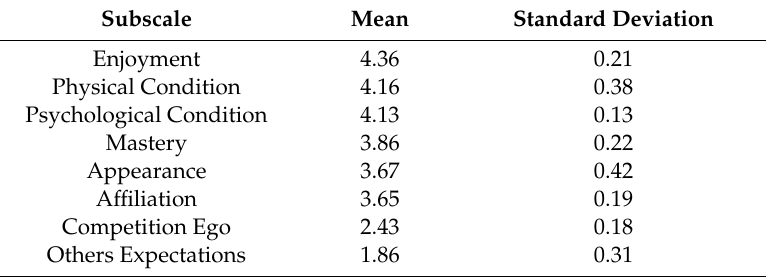
Table 2. Rank order Physical Activity and Leisure Motivation Scale (PALMS) factors (whole